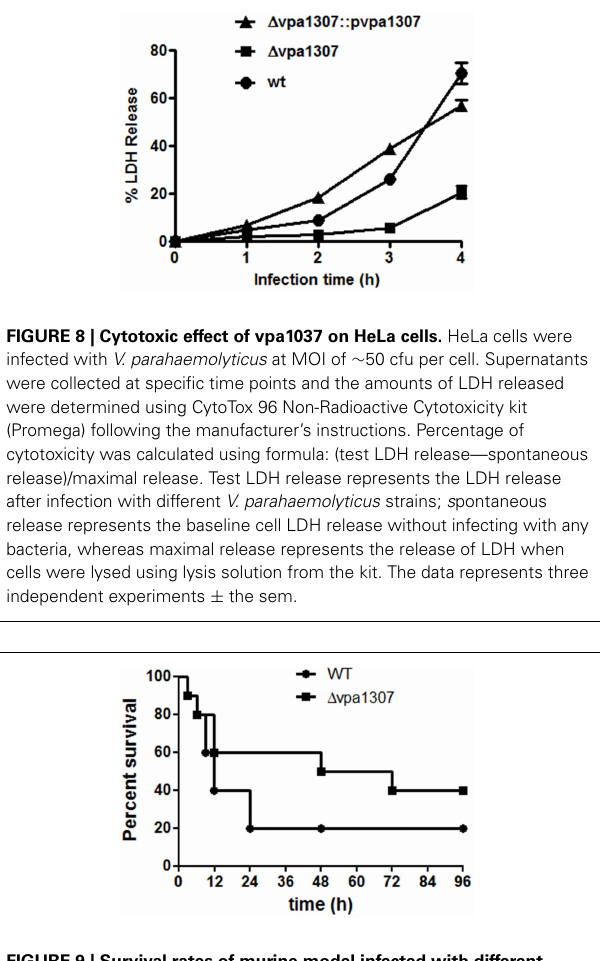
FIGURE 9 | Survival rates of murine model infected with different V. parahaemolyticus strains. C57BL/6 mice ( n = 10) were infected intraperitoneally with WT or (cid:2) vpa1307 strains (10 8 CFU) and mice were monitored for the duration of 96h. The mortality rate was measured at different time points (0, 3, 6, 9, 12, 24, 48, 72, and 96h) for three independent experiments. Each data point in the figure represents the average of the data from three experiments. Kaplan–Meier and log rank tests were used to analyze the